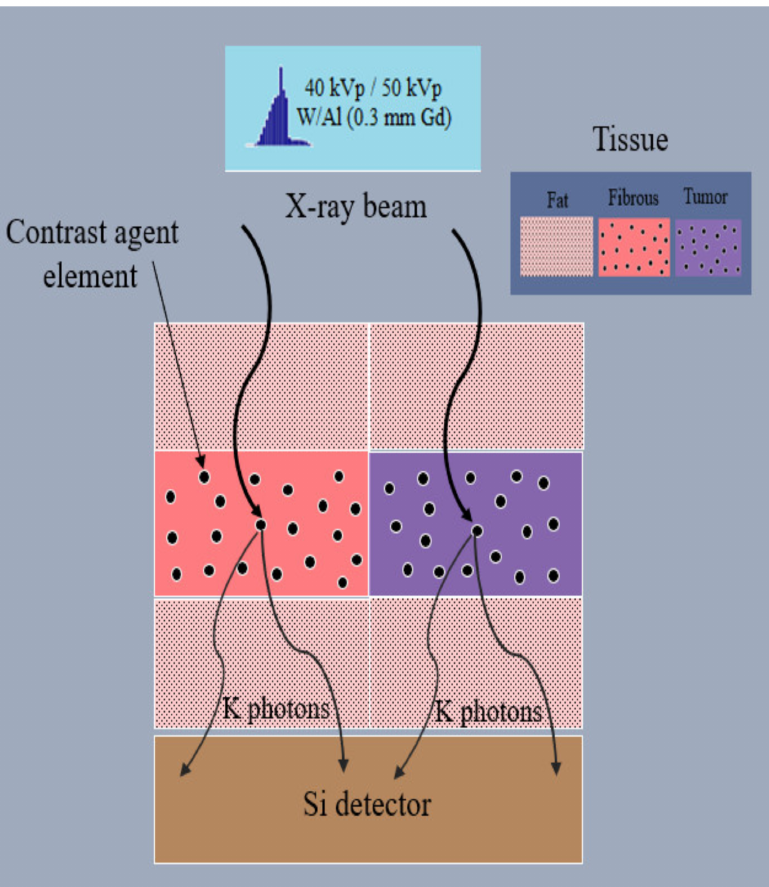
Figure 3. Figure illustrates the geometry of the model. An X-ray beam (a number of X-ray photons sampled by an X-ray spectrum corresponding to 10 mGy or 15 mGy ESAK) impinges upon two different configurations of breast tissue (external fat tissue and internal fibrous/tumor incorporating a fraction of contrast agent elements) and thereafter, by interacting through photoelectric absorption, K -X-rays are produced, emitted and finally detected by a Si converter